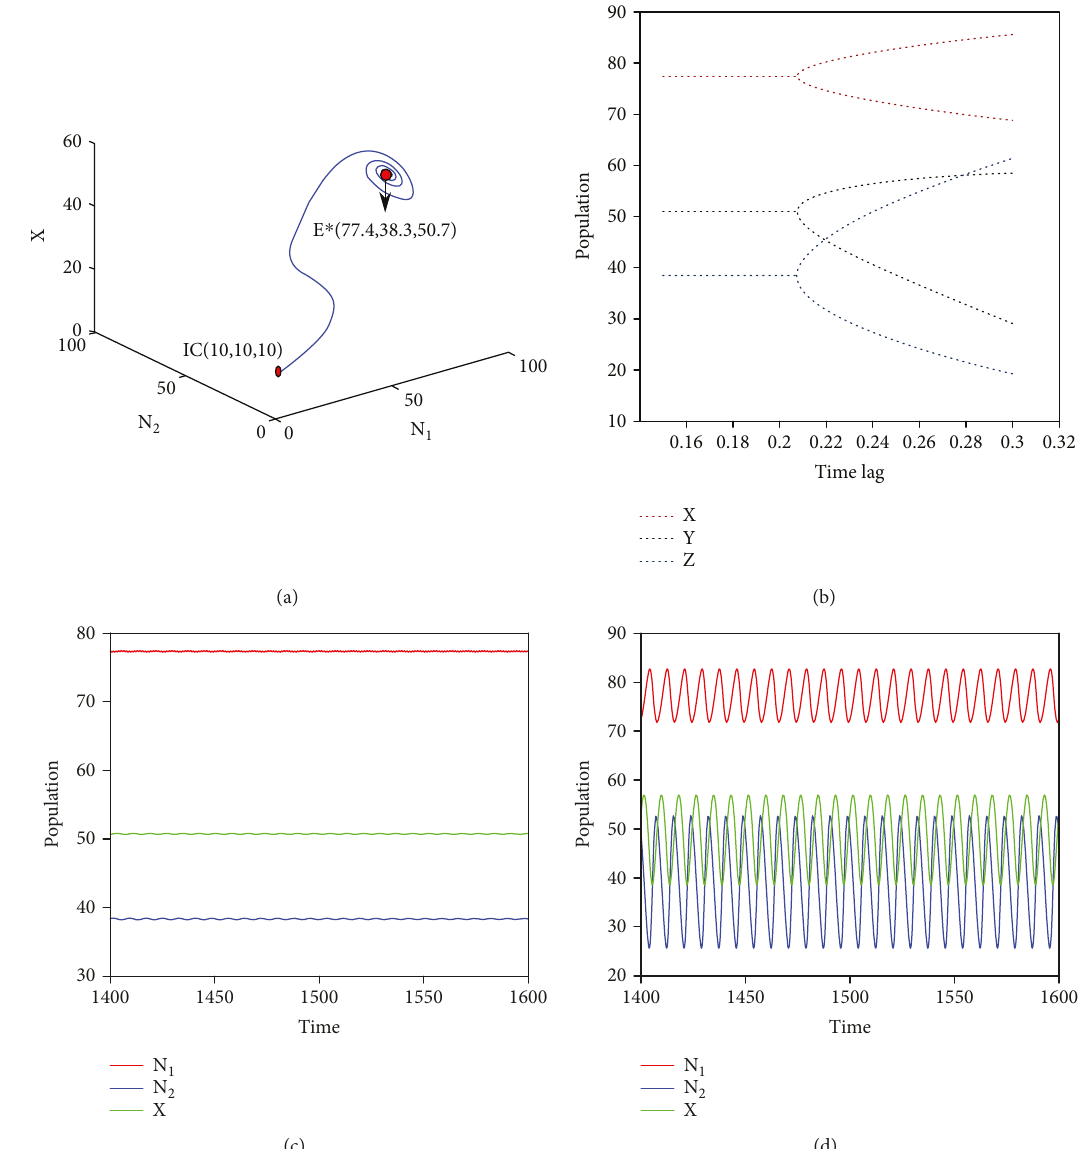
Figure 2: (a) Phase plot of nondelayed model system (1). (b) Bifurcation diagram with respect to time delay which shows that the system bifurcates at τ = 0 20757 = τ 0 . (c) Time series of system (1) remains stable for τ = 0 2 < τ 0 . (d) Time series of system (1) becomes unstable at τ = 0 25 > τ 0 . Parameters are taken as given in the